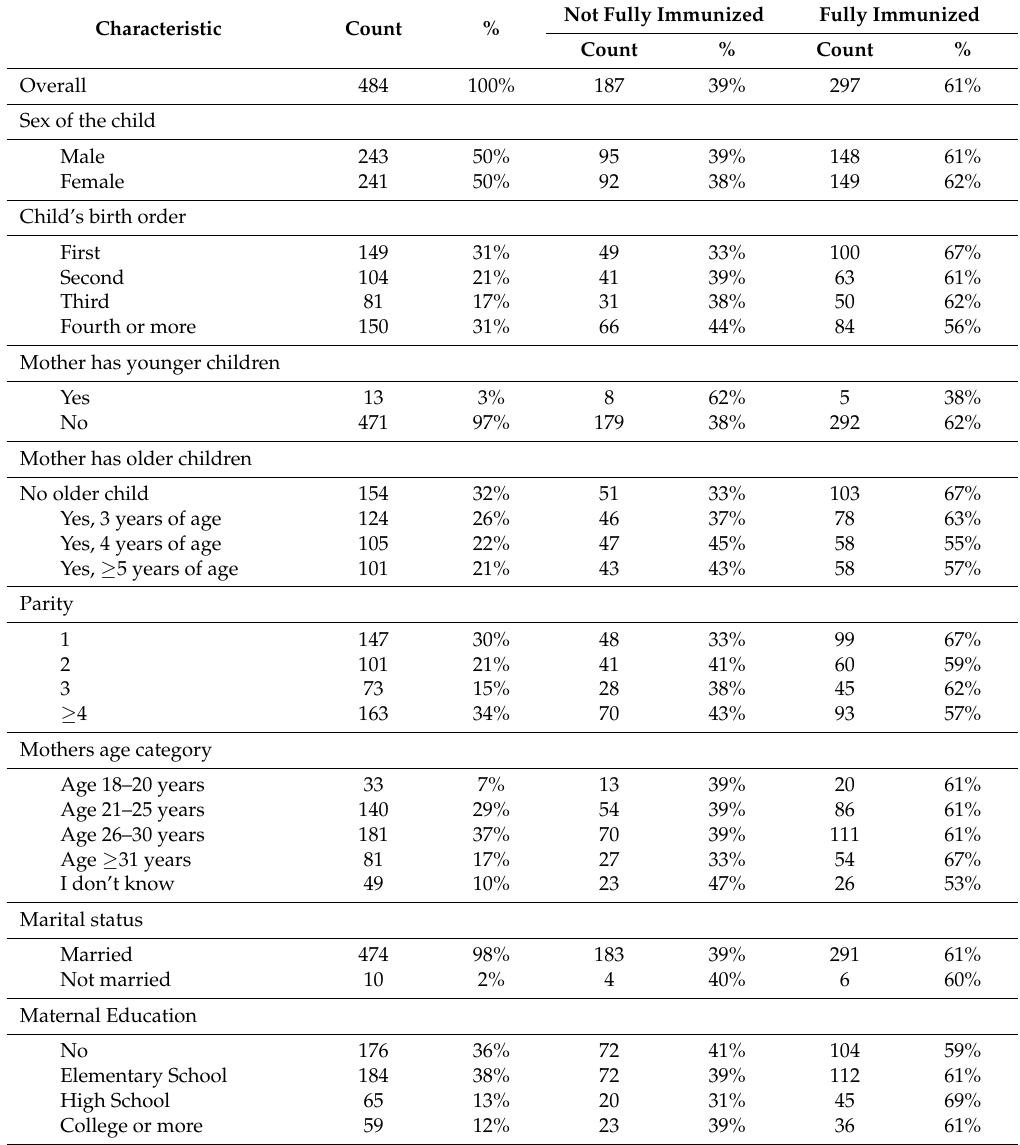
Table 1. Characteristics of children aged 12–23 months and their mothers, Worabe, Southern Nations, Nationalities, and Peoples’ Region, Ethiopia,